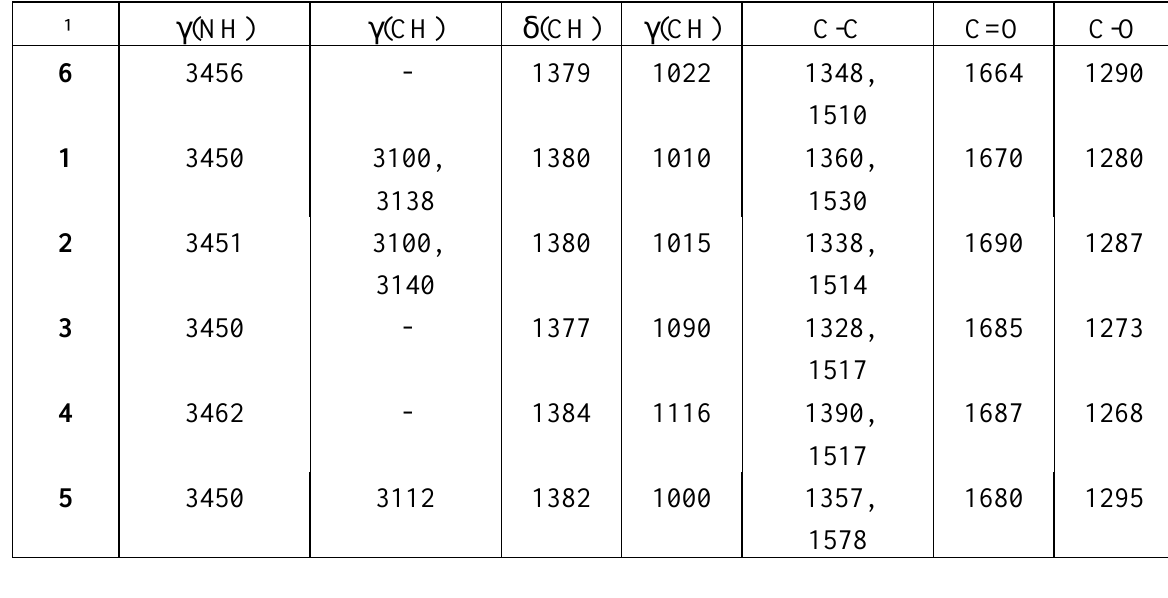
Table 1. Infrared spectra of pyrroles ( 1 - 5 ), cm -1